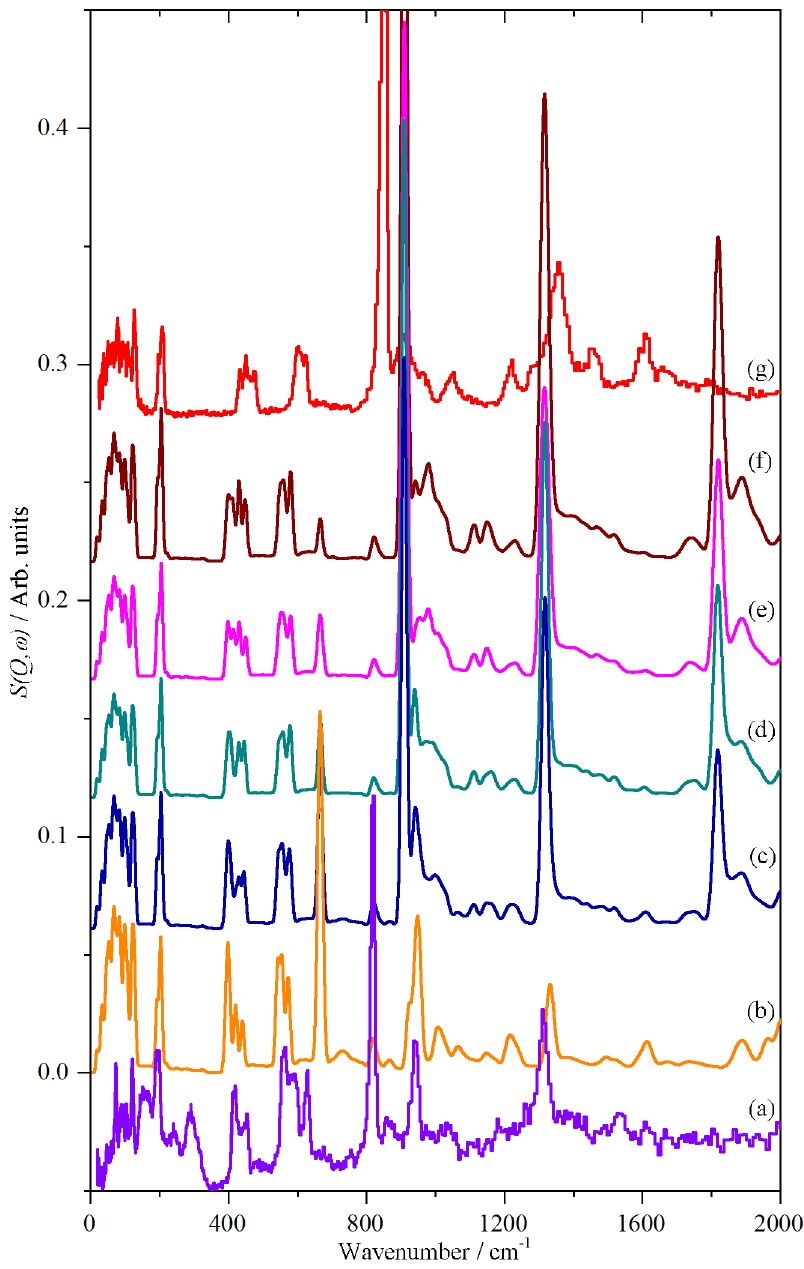
Figure 5. Observed and calculated INS spectra of CsHSO 4 isotopomers in phase II. ( a ) “CsDSO 4 ” experimental spectrum, ( b ) CsDSO 4 calculated, ( c ) CsH 0.25 D 0.75 SO 4 calculated, ( d ) CsH 0.5 D 0.5 SO 4 (D in different chains) calculated, ( e ) CsH 0.5 D 0.5 SO 4 (D in the same chain) calculated, ( f ) CsH 0.75 D 0.25 SO 4 calculated and ( g ) CsHSO 4 experimental spectrum [27]. The ordinate scale relates to ( b – f ) and are in the ratios: 1( b ):0.55( c ):0.33( d – f ).